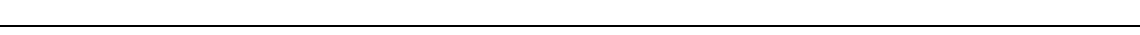
Fig. 6 Sortilin expression decreased with the tumor aggressiveness. a Boxplot diagram represents the quanti fi cation (Hirsch index) of sortilin expression in human lung adenocarcinoma ( n = 78) and highlights the high expression of sortilin at low grade, as seen in representative images in b : grade I, well- differentiated; grade II, moderately differentiated; grade III, poorly differentiated. Magni fi cation ×50, insets ×200. c Boxplot diagram of the percentage of Ki-67-positive nuclei, re fl ecting cancer cell proliferation, and tumor aggressiveness in the same patients shown in b with representative images d . Magni fi cation ×50, insets ×200. e Kaplan − Meier curves of overall survival were constructed for the following groups of patients with high (black curve, n = 248) or low (orange curve, n = 425) SORT1 expression, using the online tool at kmplot.com. f In silico analysis of SORT1 expression in lung adenocarcinoma with high or low EGFR expression; data were obtained from the MSKCC cBioPortal for Cancer Genomics database or Genome Expression Omnibus. g Quantitative PCR analyses for SORT1 and EGFR expression in a cohort of patients ( n = 20) with high or low EGFR expression. h Kaplan − Meier curves showing the survival bene fi t provided by high- SORT1 expression (black curve, n = 32) relative to low SORT1 expression (orange curve, n = 30) on a subset patients with high- EGFR expression; data were obtained from the lung adenocarcinoma cohort in the MSKCC cBioPortal database ( n = 522). i In silico analysis for SORT1 expression in lung adenocarcinoma with or without EGFR TKI − sensitive mutations, using data from the MSKCC cBioPortal for Cancer Genomics database or Genome Expression Omnibus. For Kaplan – Meier curves, the log-rank (Mantel-cox) is used test to determine the statistical signi fi cance of association sortilin high or low expression and overall survival within lung adenocarcinoma patients, * P < 0.05 ** P < 0.01 *** P < 0.001, Hazard Ratio (HR) is reported in time-to-event analysis. For Boxplot diagrams, median values are indicated by the transverse line within the box. Student ’ s t -test * P < 0.05, ** P < 0.01, *** P < 0.001. Each experiment has been repeated at least three